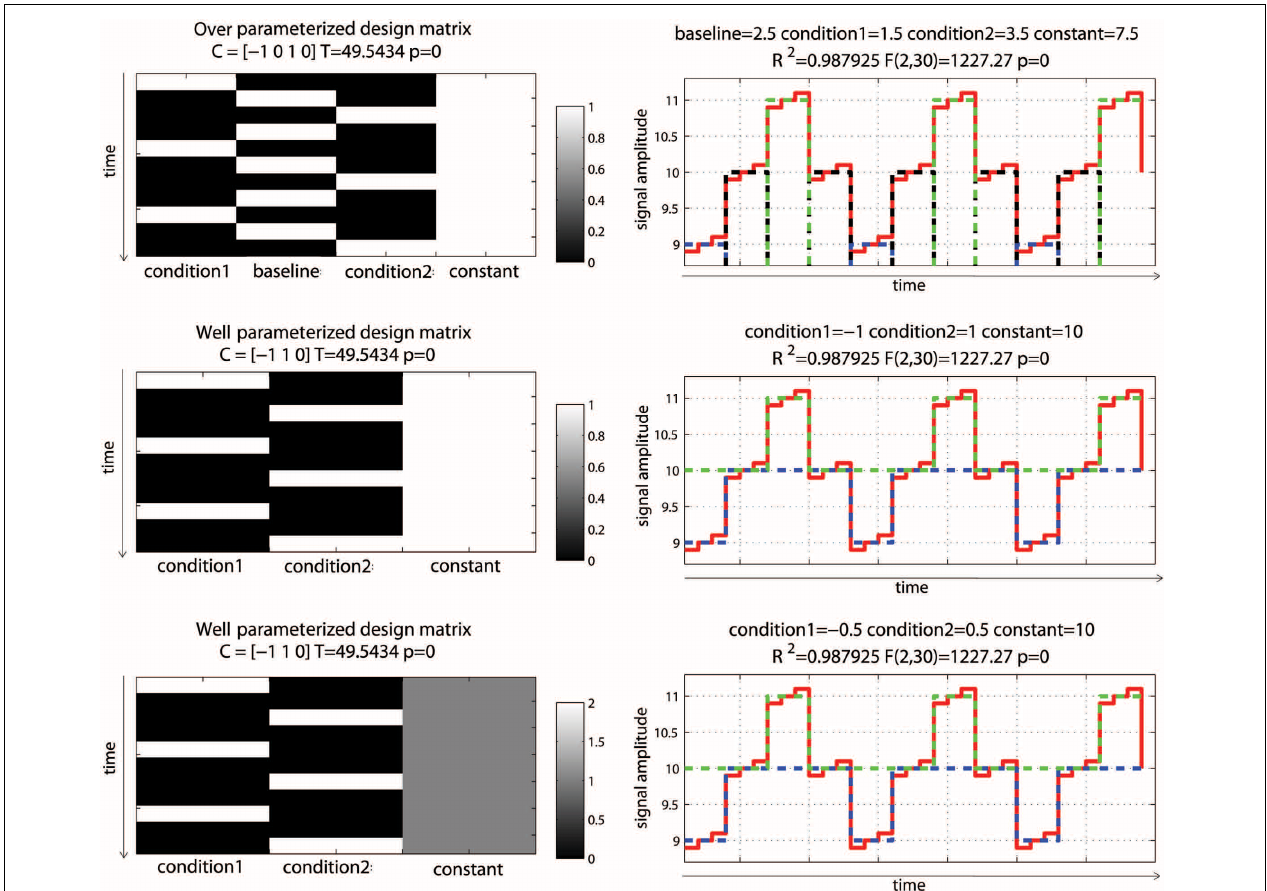
FIGURE 3 | Alternating block design with two “active” conditions and a baseline. Three different models were used: one over-parameterized one (condition 1, baseline and condition 2 were modeled— top ), and two well-parameterized ones (only conditions were modeled) but with the design matrix value either between 0 and 1 (middle) or 0 and 2 (bottom) . As illustrated on the right hand side, all 3 models fitted the data the same way, giving the same R 2 . Parameter estimates however differed. The fitted data for condition 1 are plotted in blue, for condition 2 in red and for the baseline